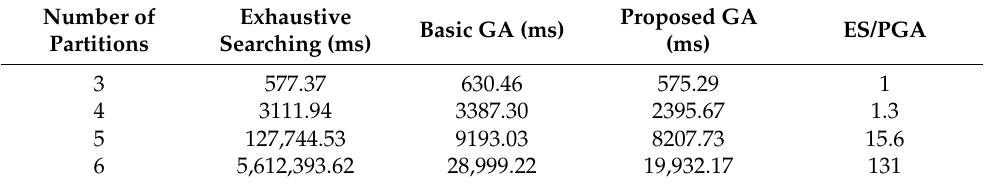
Table 5. Comparison of the average computation time for generating a deployment plan of a